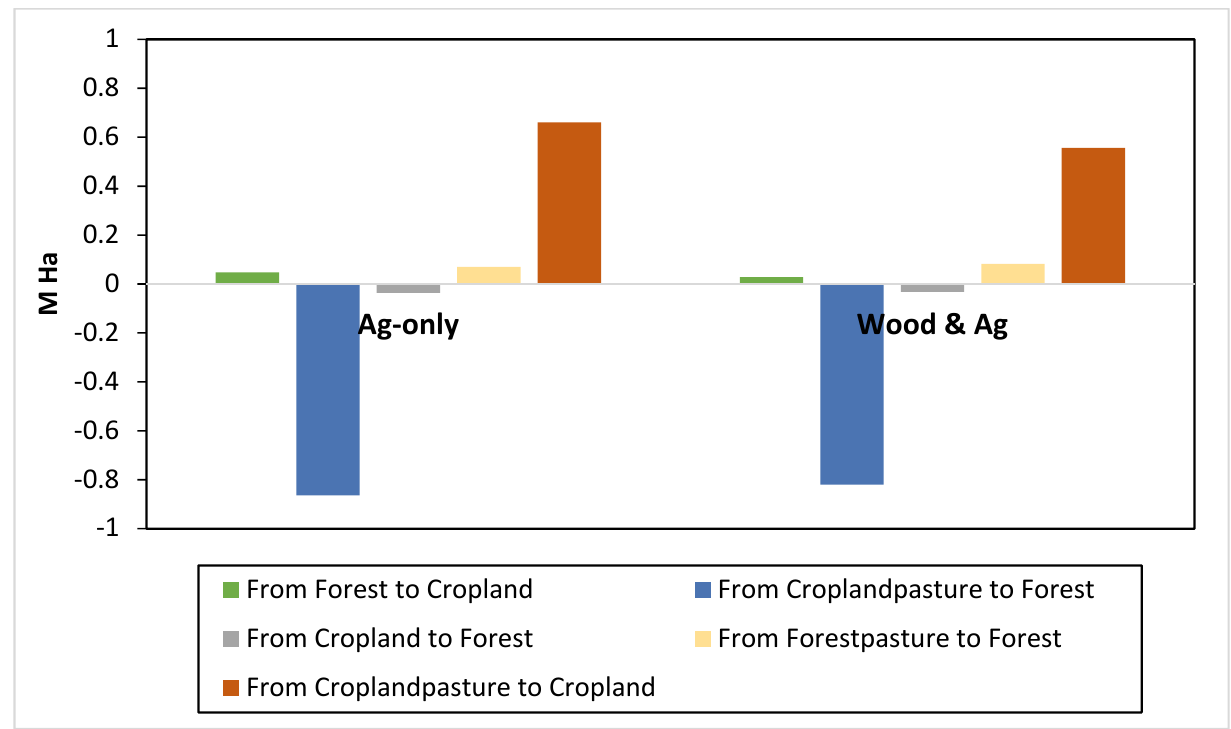
Figure 3. Land use change between 2015 and 2035 relative to the No-cell scenario. Positive values indicate an increase in land use change due to cellulosic ethanol, while negative values indicate a reduction in land use change due to cellulosic ethanol.